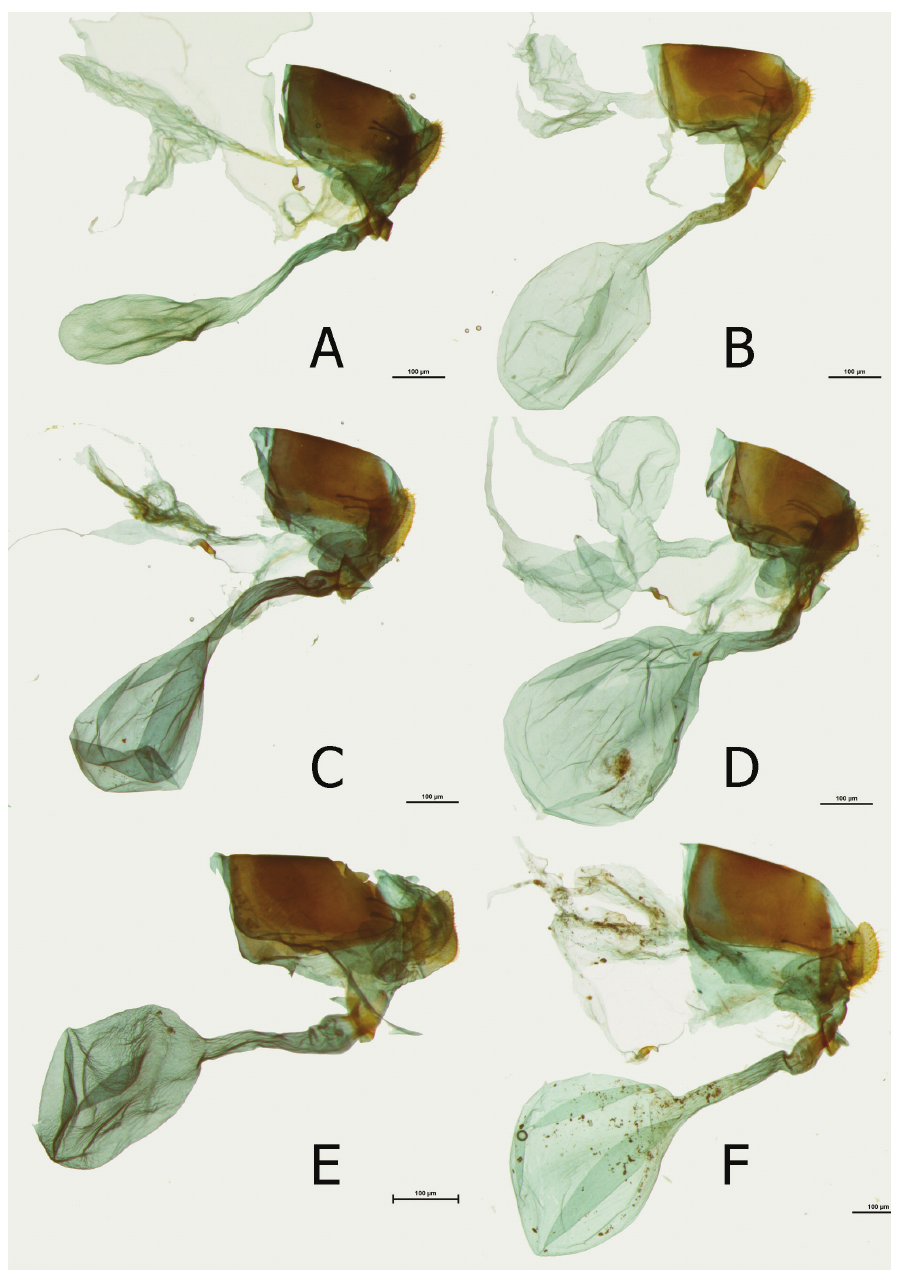
Figure 10. Female genitalia (in lateral view): A E. cyparissa aurantina Mpasso, Ghana e cyparissa aurantina Abengourou, Ivory Coast; 1 ♂ : S. Nigeria, Ewohimi, 29.XI.55, J. Boorman; 1 ♂ : no label; 2 ♂ : Cameroon, Ebogo, Mbalmayo, X.2001; 1 ♂ : Cameroon C E. cyparissa nimbina Mont Nimba, Gui- nea D E. cyparissa tai Tai, Ivory Coast e E. cyparissa aurata Obudu, Nigeria F E. cyparissa nominalina Mongorimba,